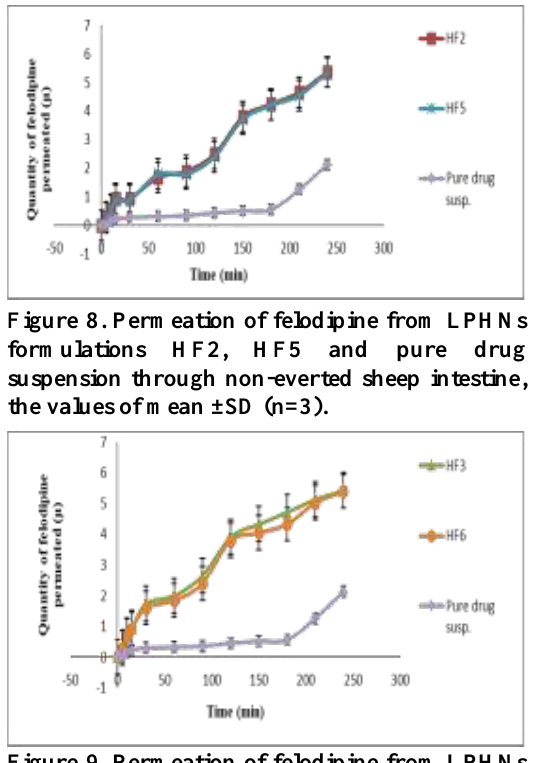
Figure 9. Permeation of felodipine from LPHNs formulations HF3, HF6 and pure drug suspension through non-everted sheep intestine, the values of mean ±SD